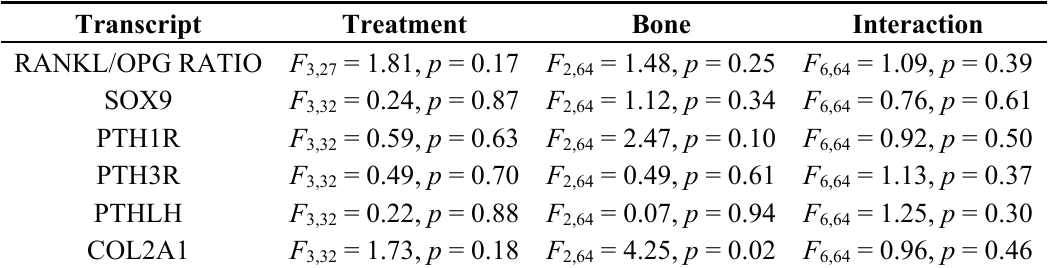
Table 2. Statistical analysis of transcripts data (F-statistic and p